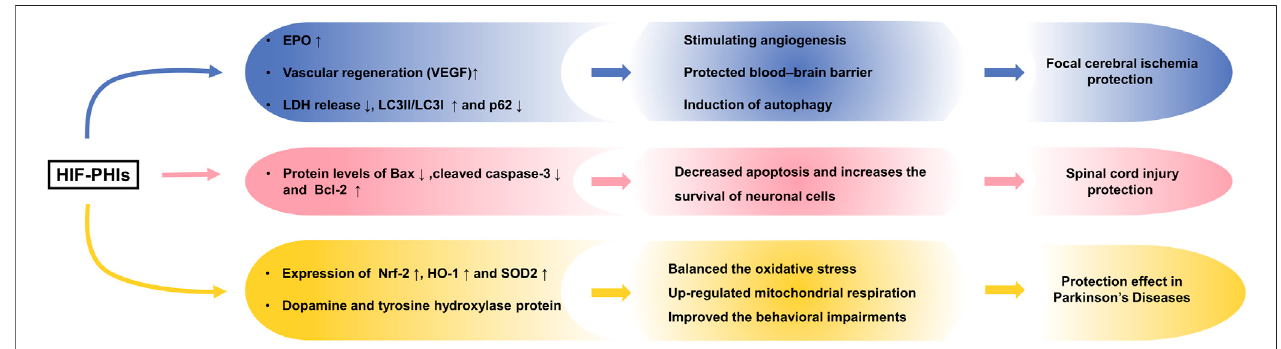
FIGURE 4 | Neuroprotection effect of HIF-PHIs. Preischemic treatment with HIF-PHIs has been shown to protect against cerebral ischemia in vivo and in vitro via elevationofEPO,protectionofthebloodbrainbarrier,andautophagyactivationofneurons.HIF-PHItreatmentsigni fi cantlyinhibitedapoptosisandincreasedthesurvival of neuronal cells with the downregulation of Bax and cleaved caspase-3 and upregulation of Bcl-2 in spinal cord injury. Additionally, HIF-PHI treatment upregulated mitochondrialrespirationandcounterbalancedoxidativestressbyupregulatingNrf-2,HO-1andSOD2andrescuingthelossofdopamineandTHprotein,showing improvedbehavioralimpairmentsinParkinson ’ sdisease.HIF-PHIs,HIFprolylhydroxylasedomainenzymeinhibitors;EPO,erythropoiesis;LDH,lactatedehydrogenase; Bcl-2, B-cell lymphoma-2; LC3, light chain 3; Bax, Bcl-2 associated X protein; Nrf2, nuclear factor erythroid-2-related factor 2; HO-1, Heme oxygenase-1; SOD2, Superoxide dismutase